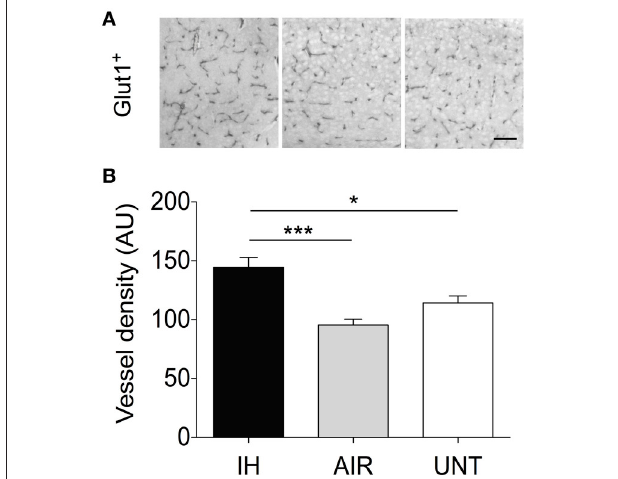
FIGURE 5 | IH-induced increase in vessel density. Vessel density was measured in the somatosensory cortex of pups postnatally exposed to intermittent hypoxia (IH, n = 5 ), exposed to air (AIR, n = 9 ), or left untreated with their dams (UNT, n = 6 ). (A) Cerebral vessels in the cortex were identified by GLUT-1 immunostaining. (B) Vessel density analysis of GLUT-1-stained sections. IH increased angiogenesis compared to AIR and UNT. Scale bar